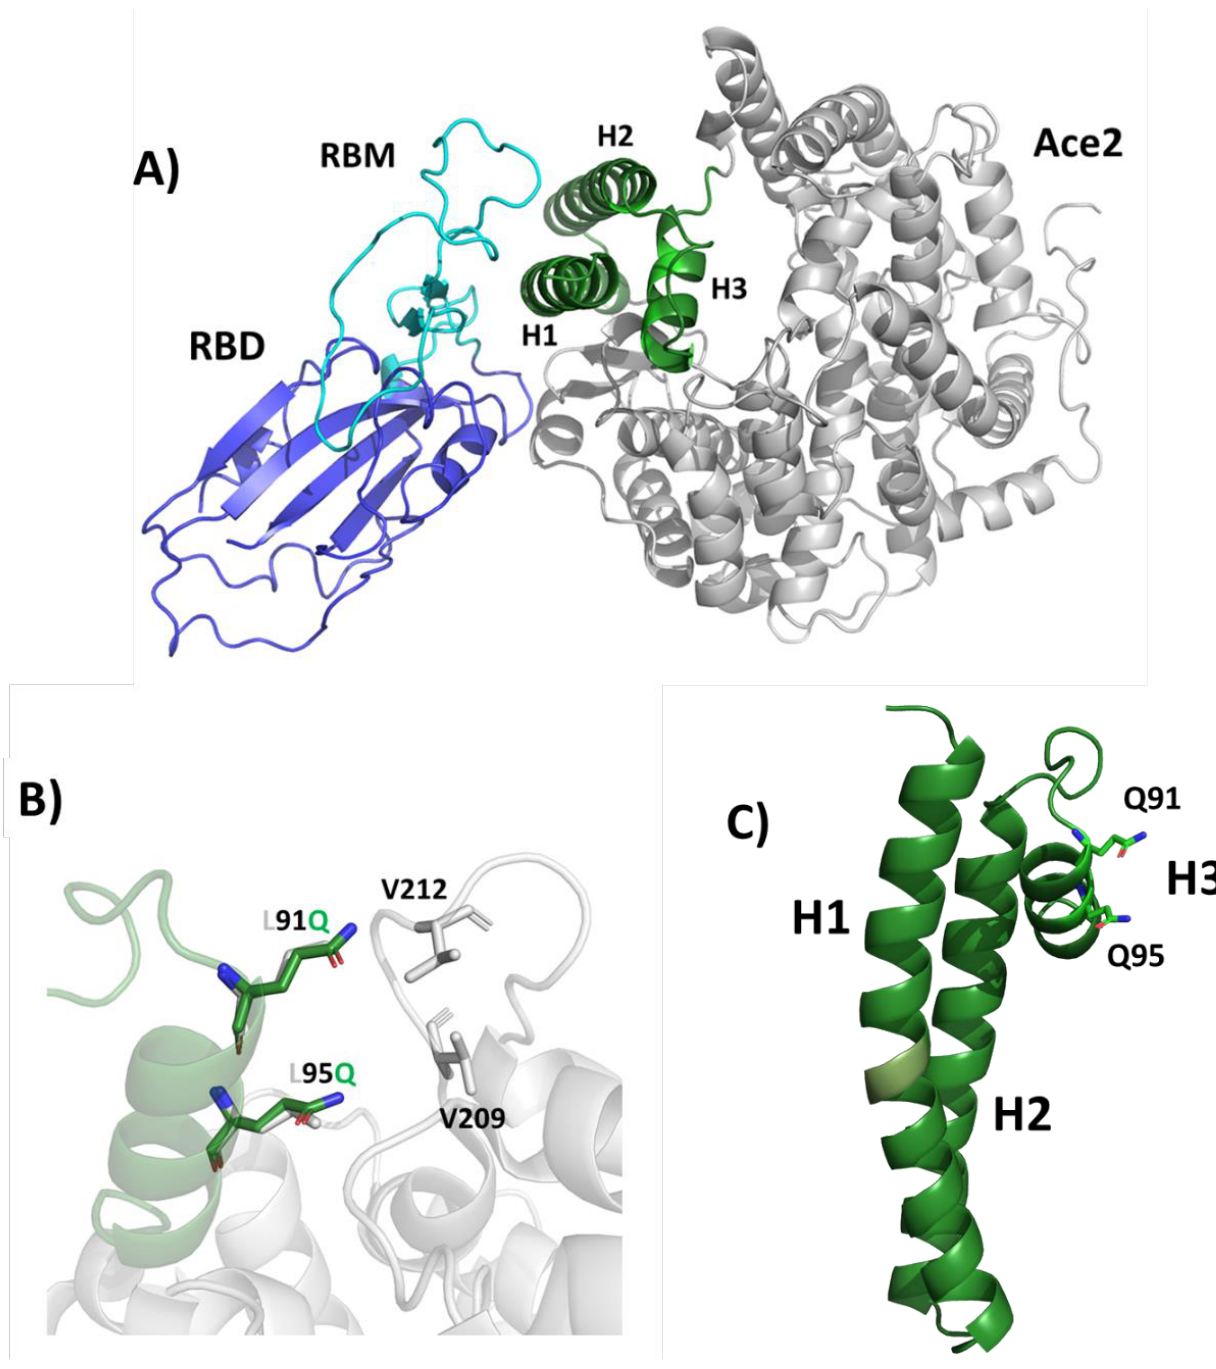
Figure 1. Design of S-plug based on spike RBD-ACE2 complex structure. ( A ) Cartoon representation of the complex between the RBD of SARS-CoV-2 spike protein (blue/cyan) and the human ACE2 receptor (grey/green). The receptor-binding motif (RBM) is drawn in cyan. The green portion of the ACE2 domain, including helices H1, H2 and H3, is drawn in green. ( B ) Cartoon representations showing the superposition of S-plug (green) on ACE2 (grey). Leu91 and Leu95, involved in hydrophobic interactions with V209 and V212 in the ACE2 structure, were mutated to glutamine residues in S-plug. ( C ) The structure of S-plug, mutated residues are shown in stick. Figures were generated with Pymol [18].